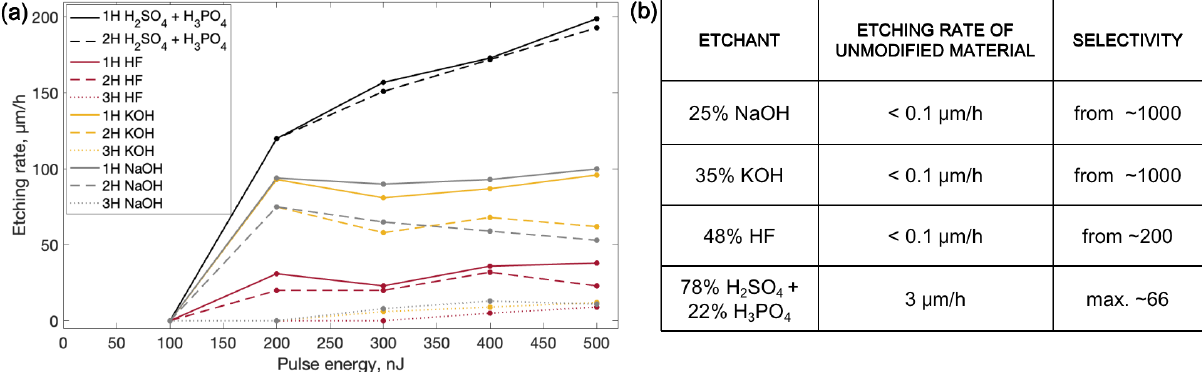
Figure 2. ( a ) Graphs of etchings rates of single lines written and etched by different processing protocols. 1H, 2H and 3H stand for 1st, 2nd and 3rd harmonics of 1030 nm wavelength laser, which is 1030 nm, 515 nm and 343 nm, respectively. ( b ) Table of the etching rate of unmodified material etched by different etchants and selectivity evaluation according to modified and unmodified material etching rate results.